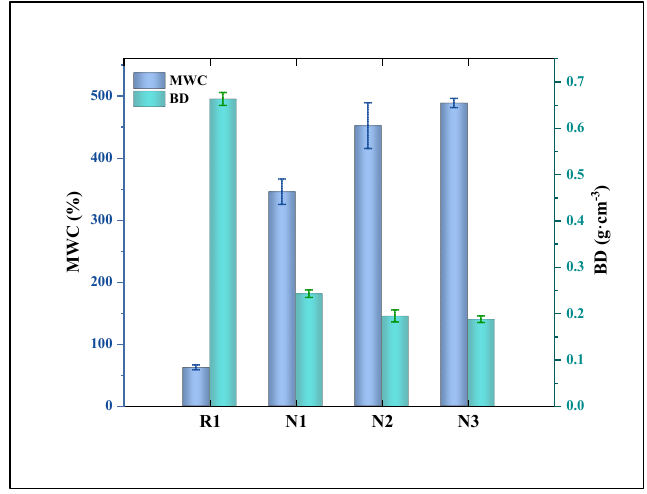
Figure 6. MWC and BD of the archaeological wood.